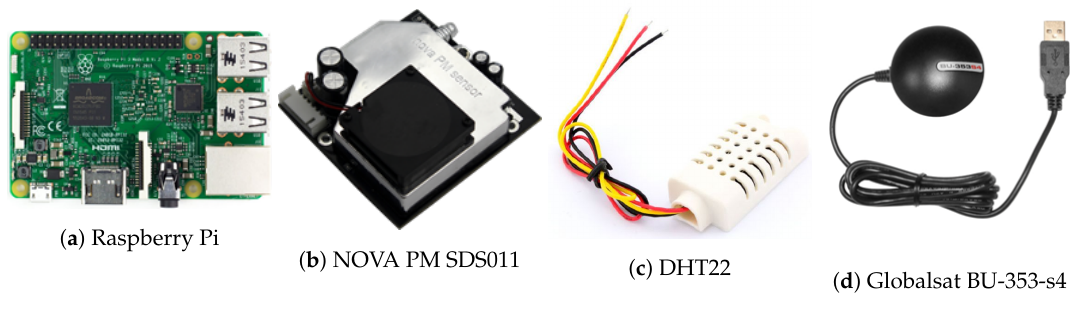
Figure 2. Hardware used in the sensor